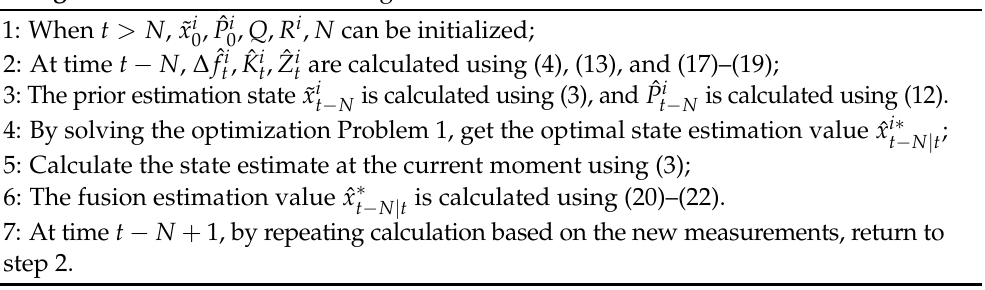
Algorithm 1: Distributed moving horizon fusion